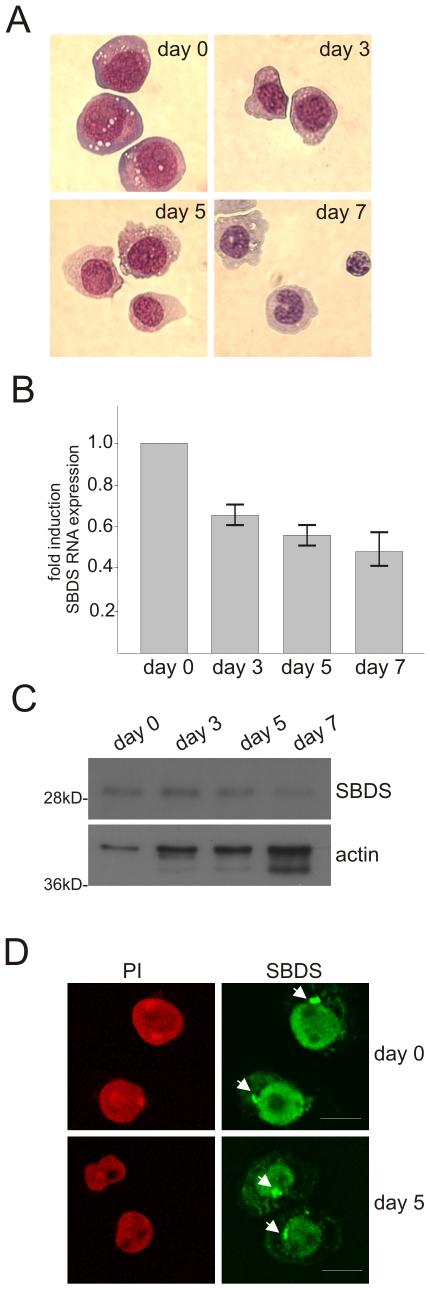
SBDS expression is downregulated during PLB-985 neutrophil differentiation.(A) PLB-985 cells were cultured for several days in the presence of 0.5% DMF to induce differentiation. May-Grünwald-Giemsa staining of cytospins of differentiating PLB-985 cells. (B) Representative quantitative RT-PCR analysis shows that SBDS mRNA expression decreases 1.8 fold with PLB-985 neutrophil differentiation (n = 5), showing the mean±SEM. (C) Western blot analysis for SBDS expressing levels and actin as a protein loading control in undifferentiated (day 0) and differentiating (day 3–7) PLB-985 cells shows that SBDS protein expression decreases during neutrophil differentiation (representative for n = 5 independent cellular differentiation experiments). (D) Immunofluorescence staining for SBDS shows that SBDS localizes prominently to the nucleus (counterstained with propidium iodide) and to lower extent in the cytoplasm. A prominent perinuclear SBDS-enriched structure (indicated with the arrow head) was detected in PLB-985 cells.